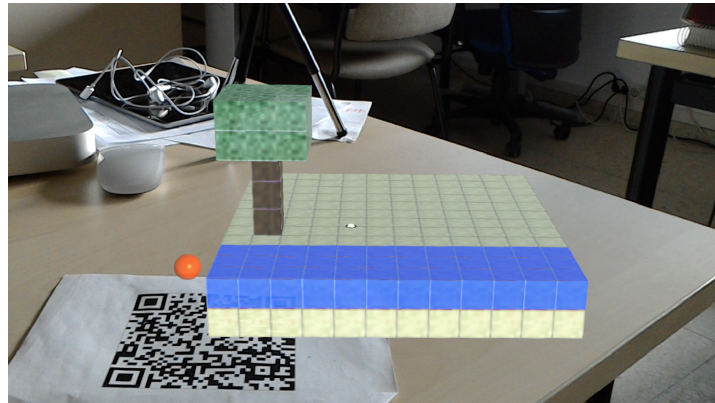
Figure 15. Capture of the voxel-based prototype taken from the HoloLens